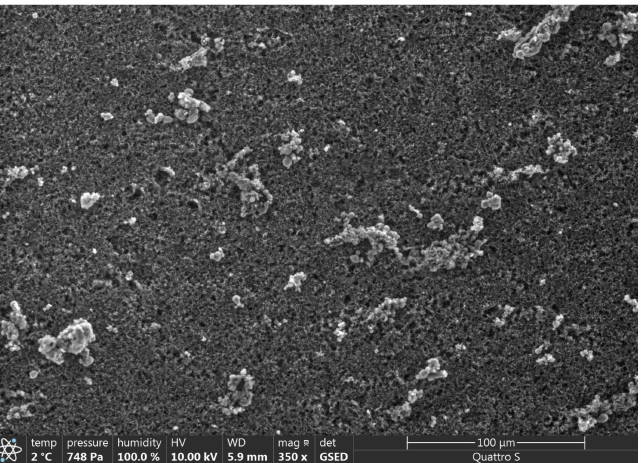
Figure 3. Illustration showing the magnification of Product K (350 × ). Multiple impurity particles were observed.